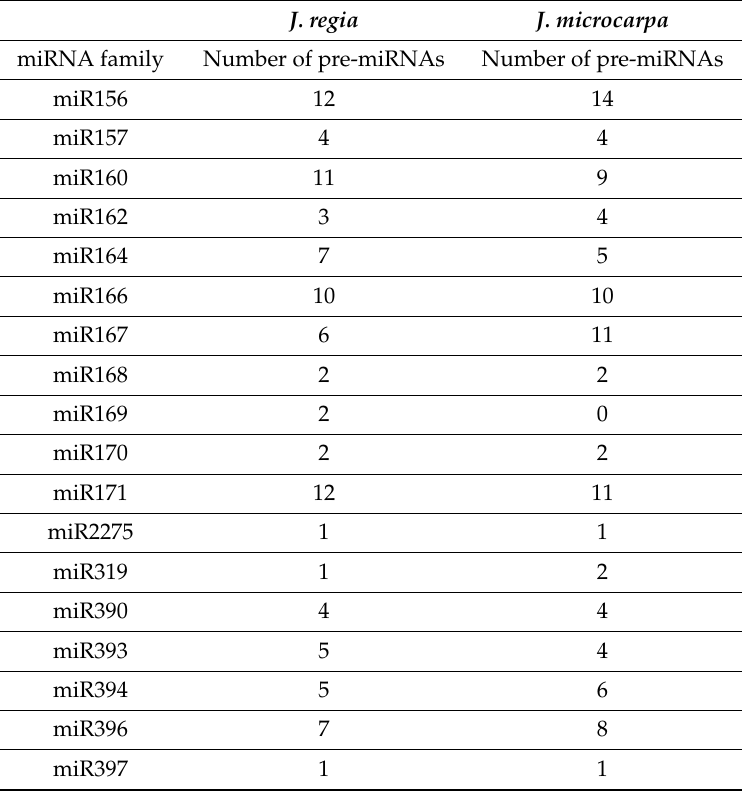
Table 1. MicroRNA families identified in J. regia and J. microcarpa . J.